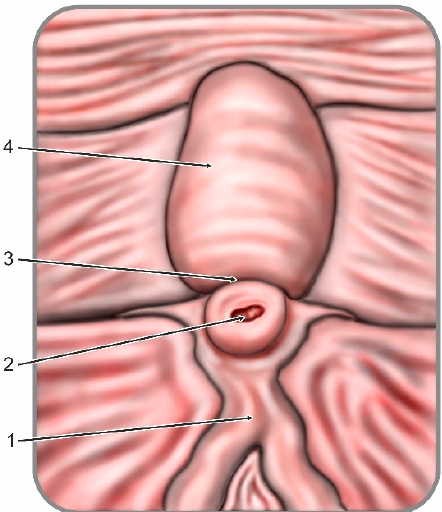
Figure 1. Regular anatomy of the papilla: (1) frenulum; (2) orifice; (3) recessus; and (4) infundibulum. Adapted after Canard et al., 2011 [17].